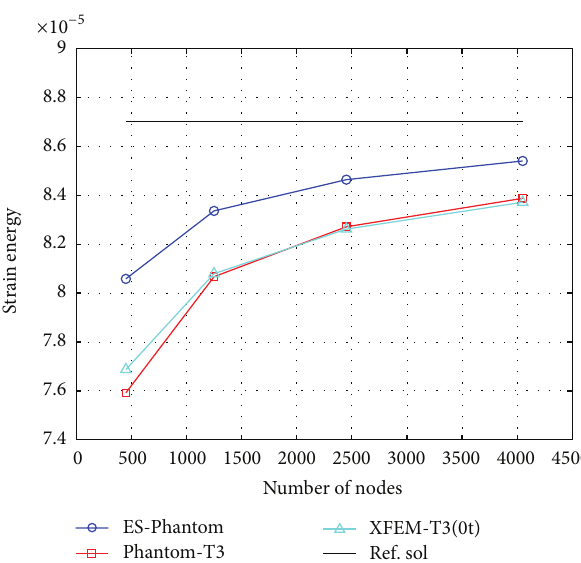
Figure 19: The convergence in the energy norm of XFEM versus ℎ (mesh size) for a sheet with an edge crack under